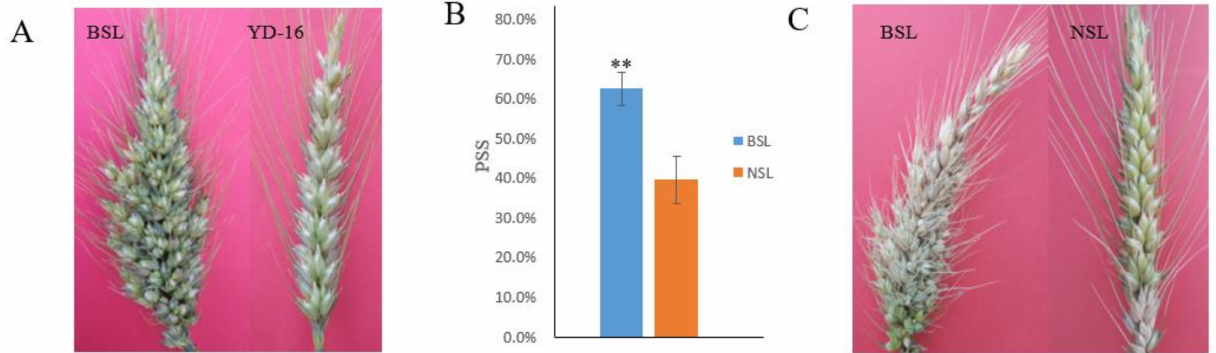
Figure 1. Comparisons of the spike architecture and FHB resistance of the BSL and the NSL plants. The mutant has branched spikelets (BSL), and the wild type has normal spikelets (NSL). ( A ) Spike morphological characteristics of the BSL mutant and the wild-type YD-16. ( B , C ) Contrasting FHB resistance levels of the BSL plants and the NSL plants after artificial inoculation. The PSS was calculated by infected spikelets/total spikelets in 21 days after